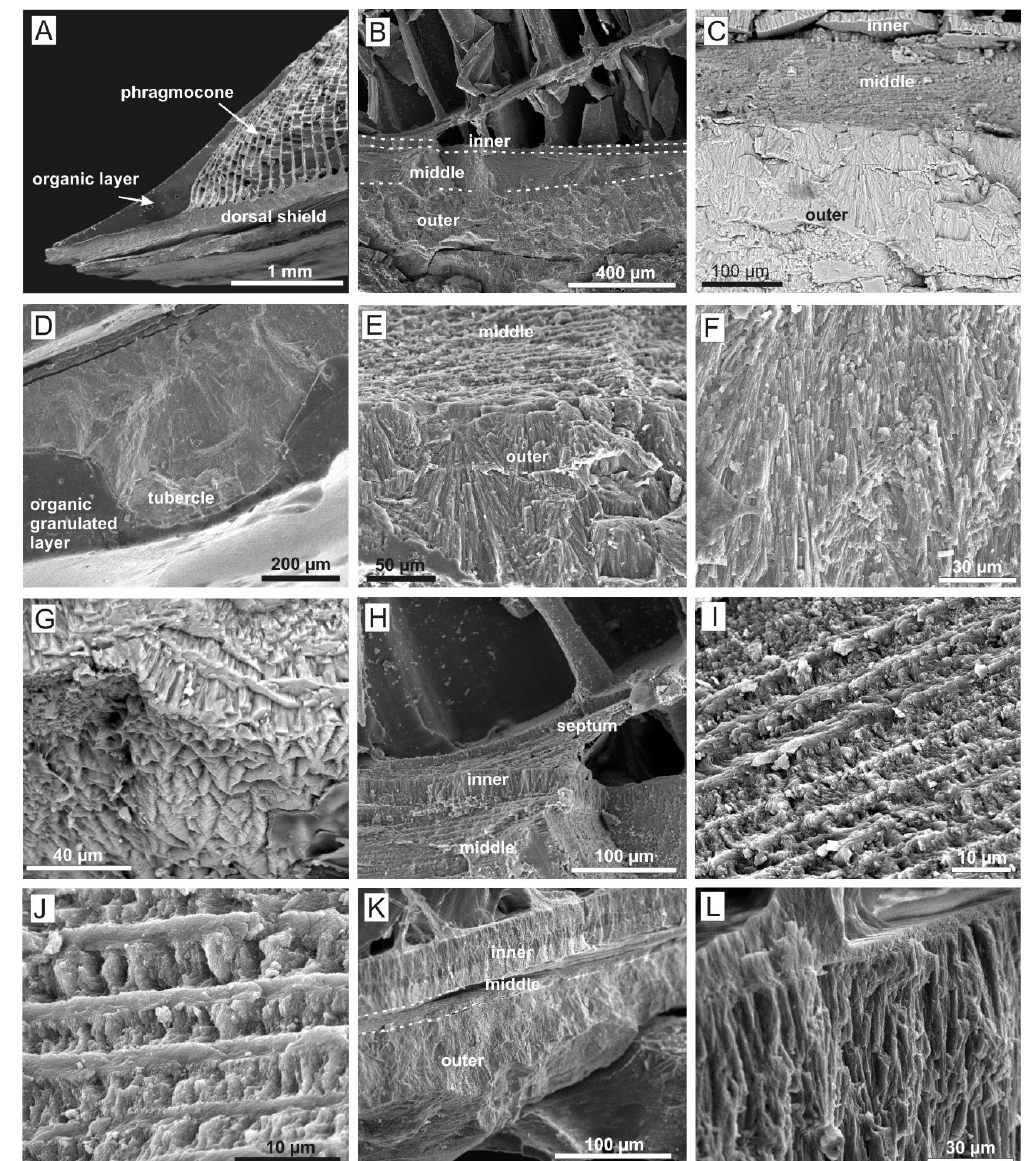
Figure 12. SEM images of the dorsal shield of S. officinalis . ( A ) Distal end of the cuttlebone (SP-03) with the contact between dorsal shield and the youngest chambers of the phragmocone. ( B ) The three mineralized layers of the dorsal shield, from the inner one, close to the phragmocone, to the outer one, in contact with the organic layer (SP-03). ( C ) BSEM image (SP-02) of the mineralized layers: the inner layer (prismatic microstructure); the middle layer (laminated microstructure, composed of organic-rich lamellar sublayers alternating with aragonitic prismatic sublayers); the outer layer (radially arranged crystals of aragonite with low presence of organic matter). ( D ) Outer layer with presence of tubercles in the contact with the external organic granulated layer (SP-07). ( E ) Differences between the microstructure of the outer and the middle layers (SP-07). ( F , G ) Radially arranged aragonite crystals of the outer layer (SP-07), which resemble hemispheres ( G ). ( H ) Prismatic microstructure of the inner layer and structural relation with the septum and the middle layer of the dorsal shield (SP-07). ( I , J ) Laminated structure of the middle layer with alternating organic-rich and aragonitic-rich sublayers (SP-07). ( K , L ) BSEM image in the distal part of the cuttlebone where the middle layer is very thin (SP-07). Radially arranged crystals of the inner layer growth from the middle layer to the phragmocone (laminated appearance due the organic matter content).